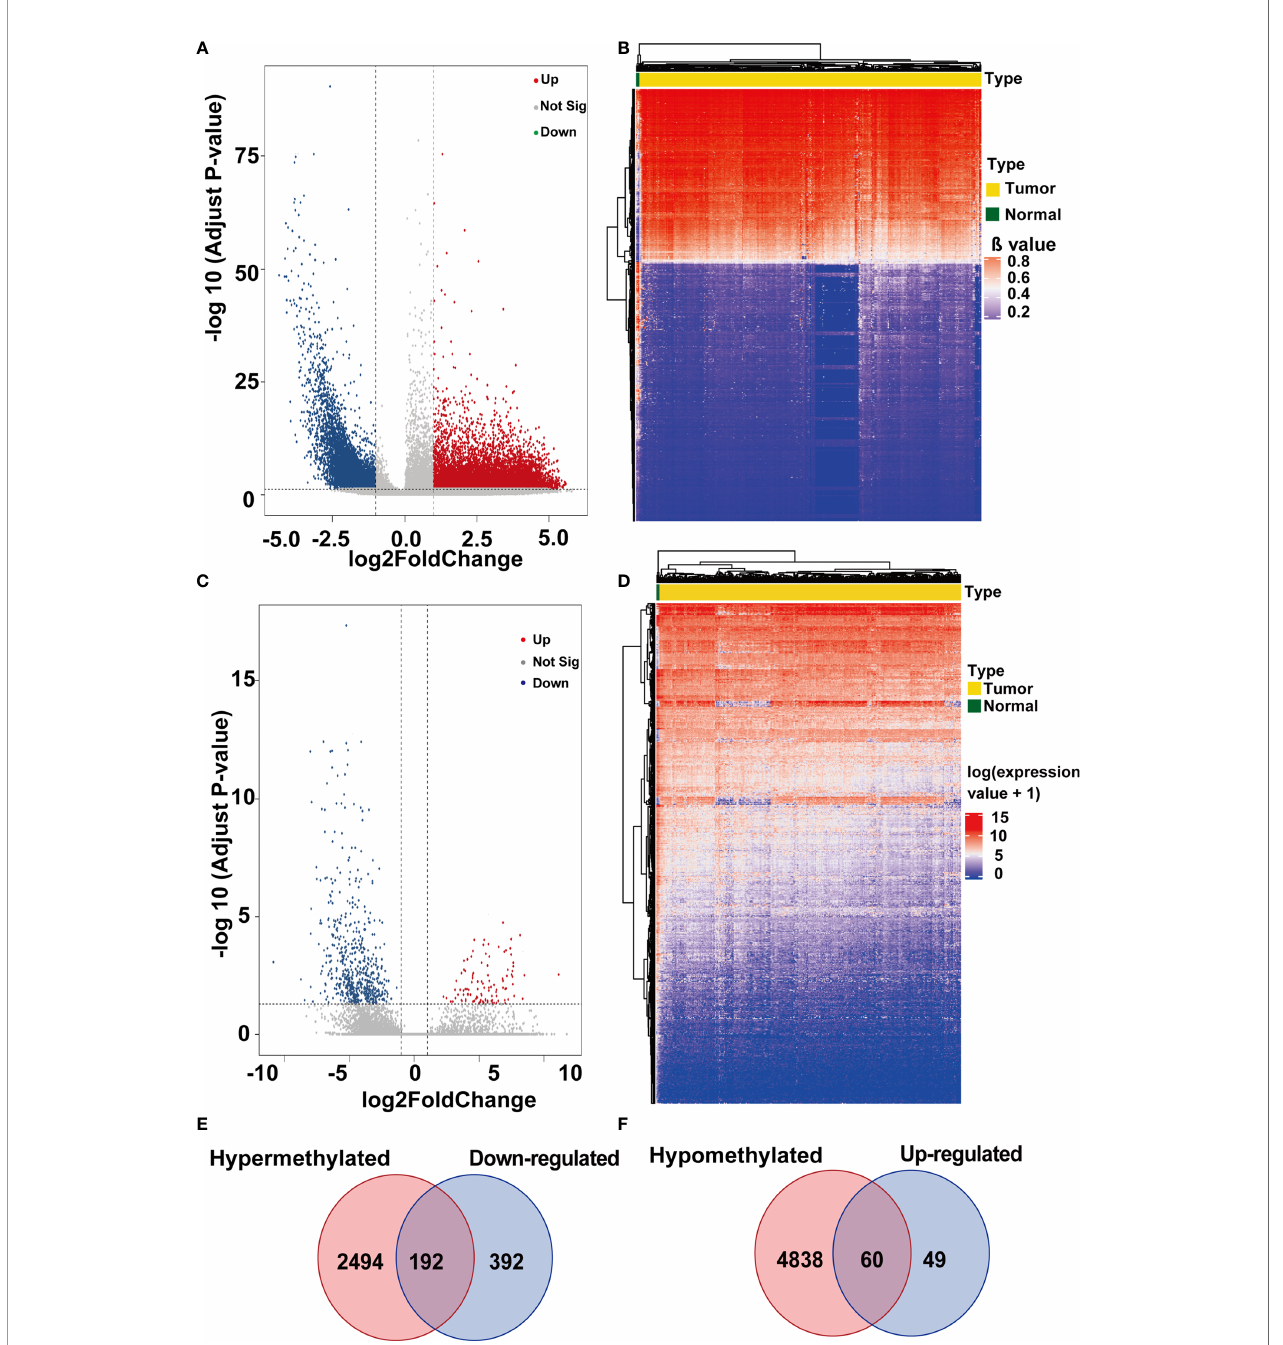
FIGURE 2 | The differentially methylated genes (DMGs) and differentially expression genes (DEGs) from TCGA-CESC database. (A) The volcano plot was constructed using log2fold change and − log10 (padj) values. Red plots represent the up-regulated CpG sites, green plots represent the down-regulated CpG sites, and black plots show those CpG sites that are not differentially expressed. (B) Heatmap of methylation values for top 1000 CpG sites methylated in cervical cancer patients. CpG sites are shown in the vertical columns and the cervical cancer samples in the horizontal rows. High methylation levels are displayed in red and low methylation levels in blue, according to the scale bar in the right of fi gure. (C) The volcano plot was constructed using log2 fold change and − log10 (padj) values. Red plots represent the up-regulated genes, green plots represent the down-regulated genes, and black plots show those genes that are not differentially expressed. (D) Heatmap of methylation values for DEGs in cervical cancer patients. The genes are displayed in the vertical columns and the cervical cancer samples in the horizontal rows. High expression levels are shown in red and low expression levels in blue, according to the scale bar in the right of the fi gure. (E) Venn diagrams of the genes relevant to hypermethylated/down-regulated genes. (F) Venn diagrams of the genes relevant to hypormethylated/up-regulated